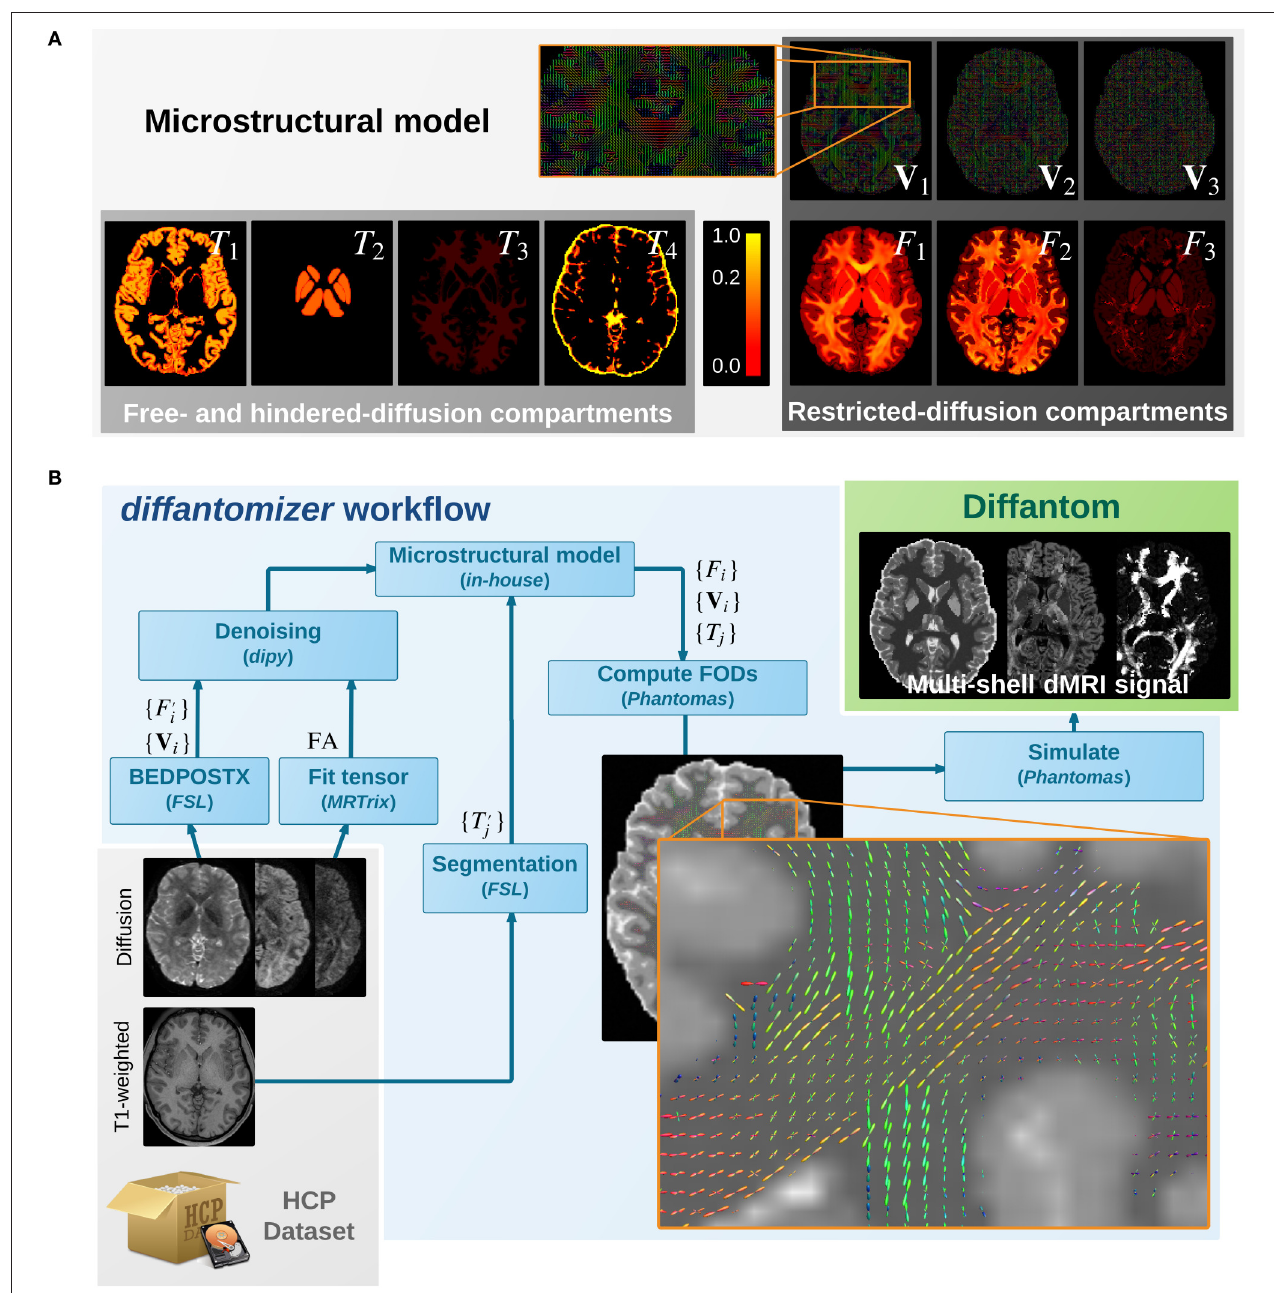
FIGURE 1 | (A) Microstructural model of Diffantom . The phantom is simulated from an underlying microstructural model specified with the following volume-fraction maps: three hindered-diffusion compartments { T 1 , T 2 , T 3 } , one free-diffusion compartment T 4 corresponding to the CSF, three restricted-diffusion compartments { F i } , and three vectorial maps associated with the local fiber directions { V i } . Please note the piece-wise linear function of the color scale to enable visibility of small volume fractions. (B) The diffantomizer workflow, a workflow to generate diffantoms . The pipeline to generate phantoms from any HCP dataset is presented in the lower panel. Once the microstructural model shown in the upper panel has been prepared as described in Microstructural Model, the local orientations are computed and fed into Phantomas to finally simulate the signal.